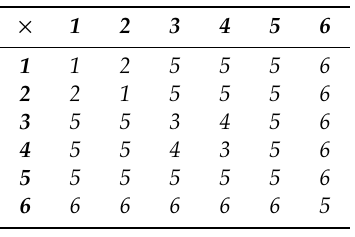
Table 6. The operation × on S